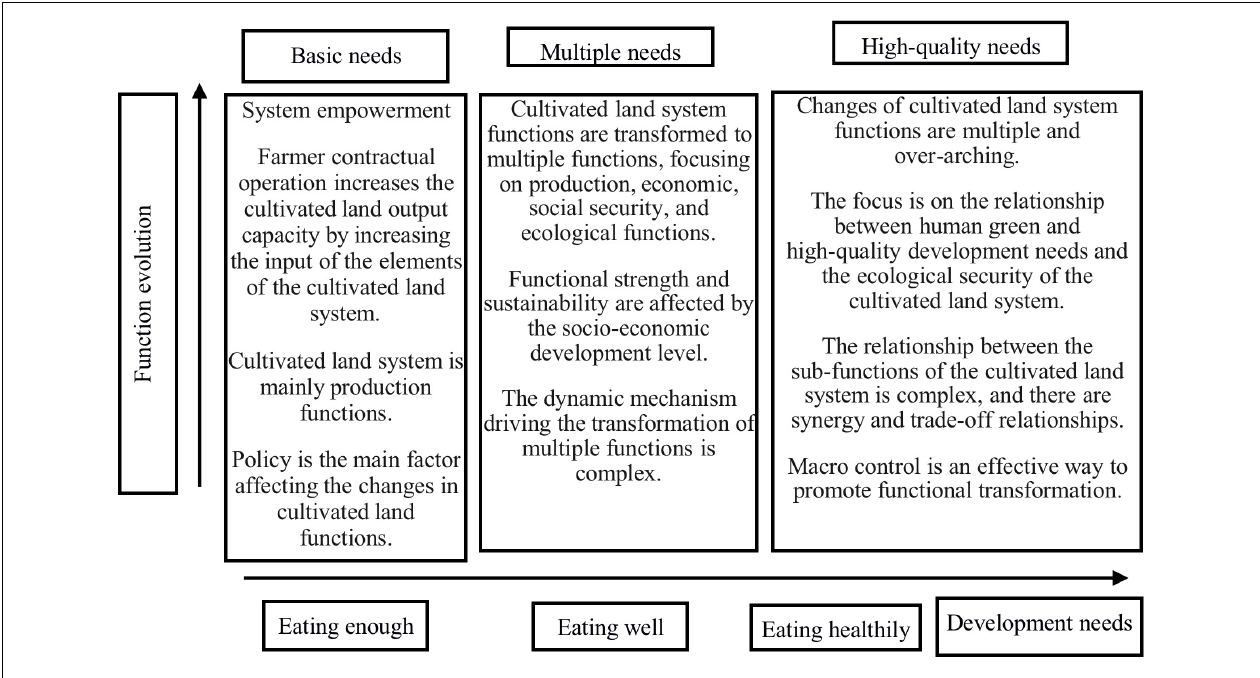
FIGURE 2 | Research framework